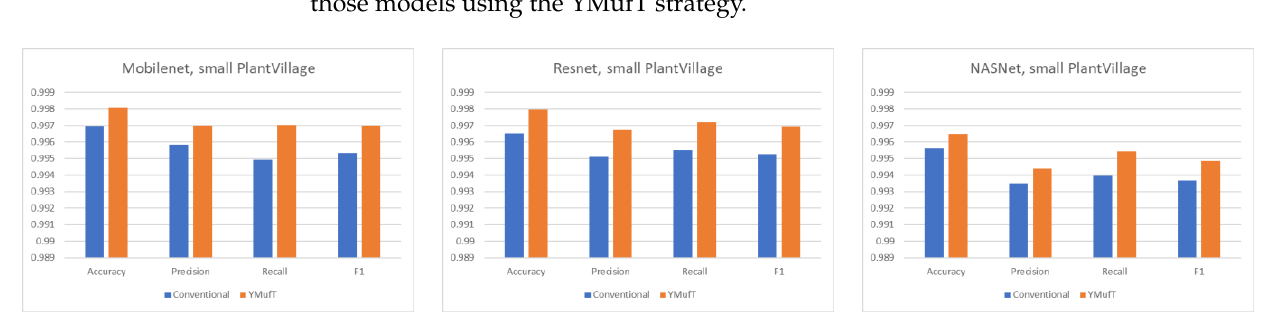
Figure 18. Average overall performance of 5-fold cross-validation on the small PlantVillage dataset.